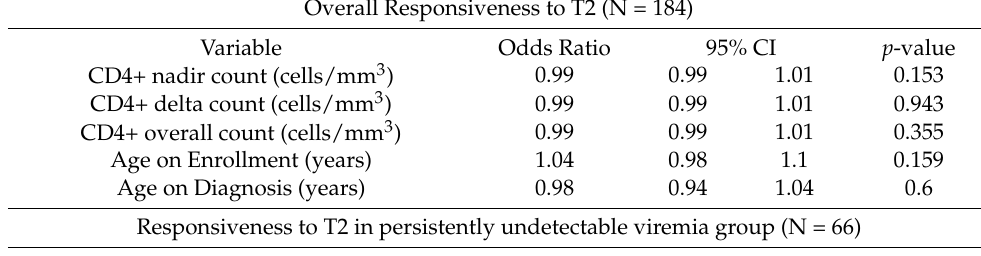
Table 3. Logistic analysis of responsiveness to T2, overall and by viremic